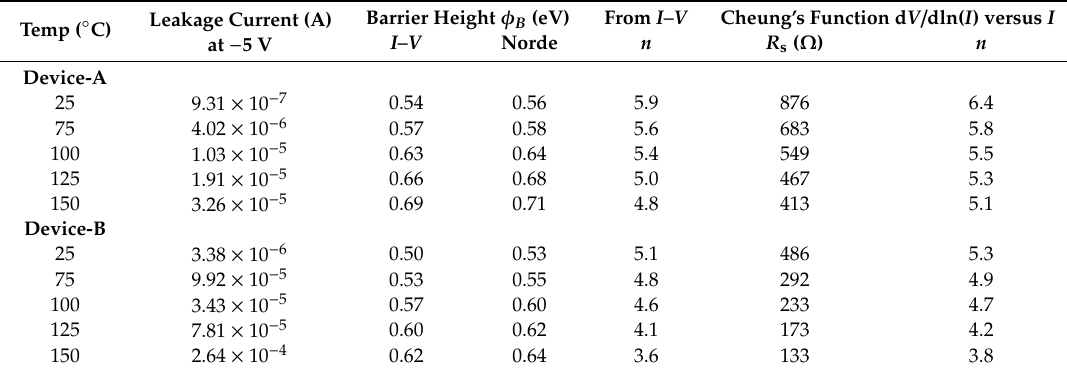
Table 1. The parameters calculated from electrical characteristics of hetero junction diodes as a function of testing